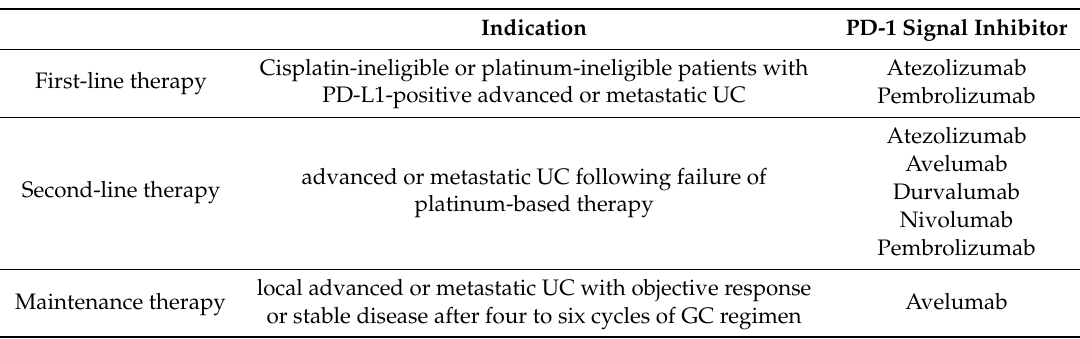
Table 1. The indication and therapeutic regimen of programmed death 1 (PD-1) signal inhibitor approved by the U.S Food and Drug Administration